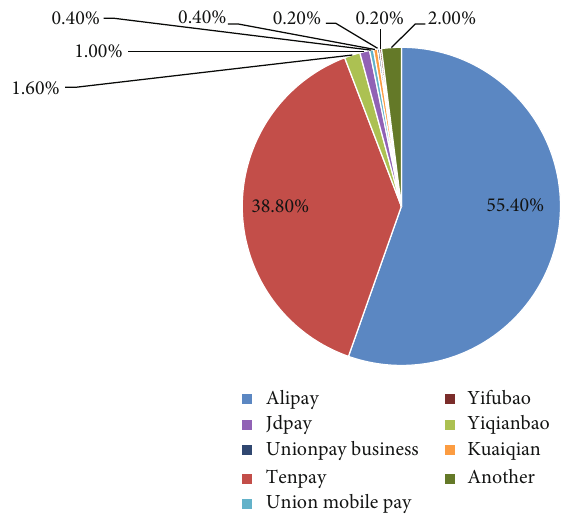
Figure 2: Third-party payment institution ’ s market share. Data resource: